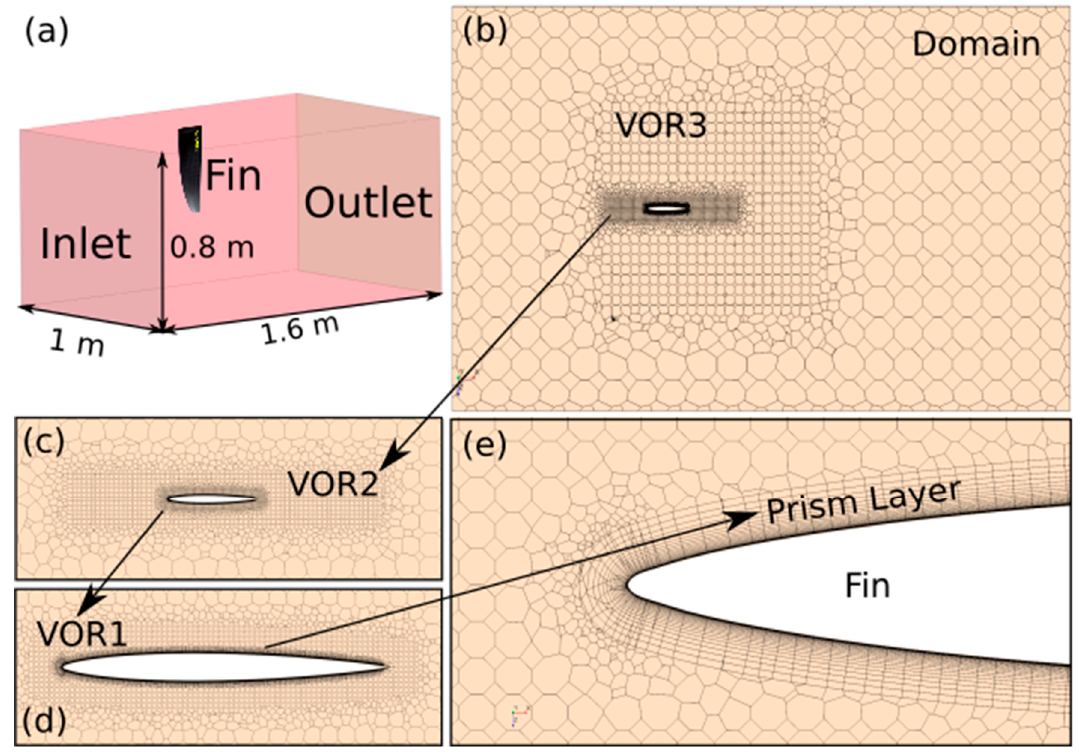
Figure 5. Computational fluid domain ( a ), boundary surfaces and mesh refinements ( b – e ).